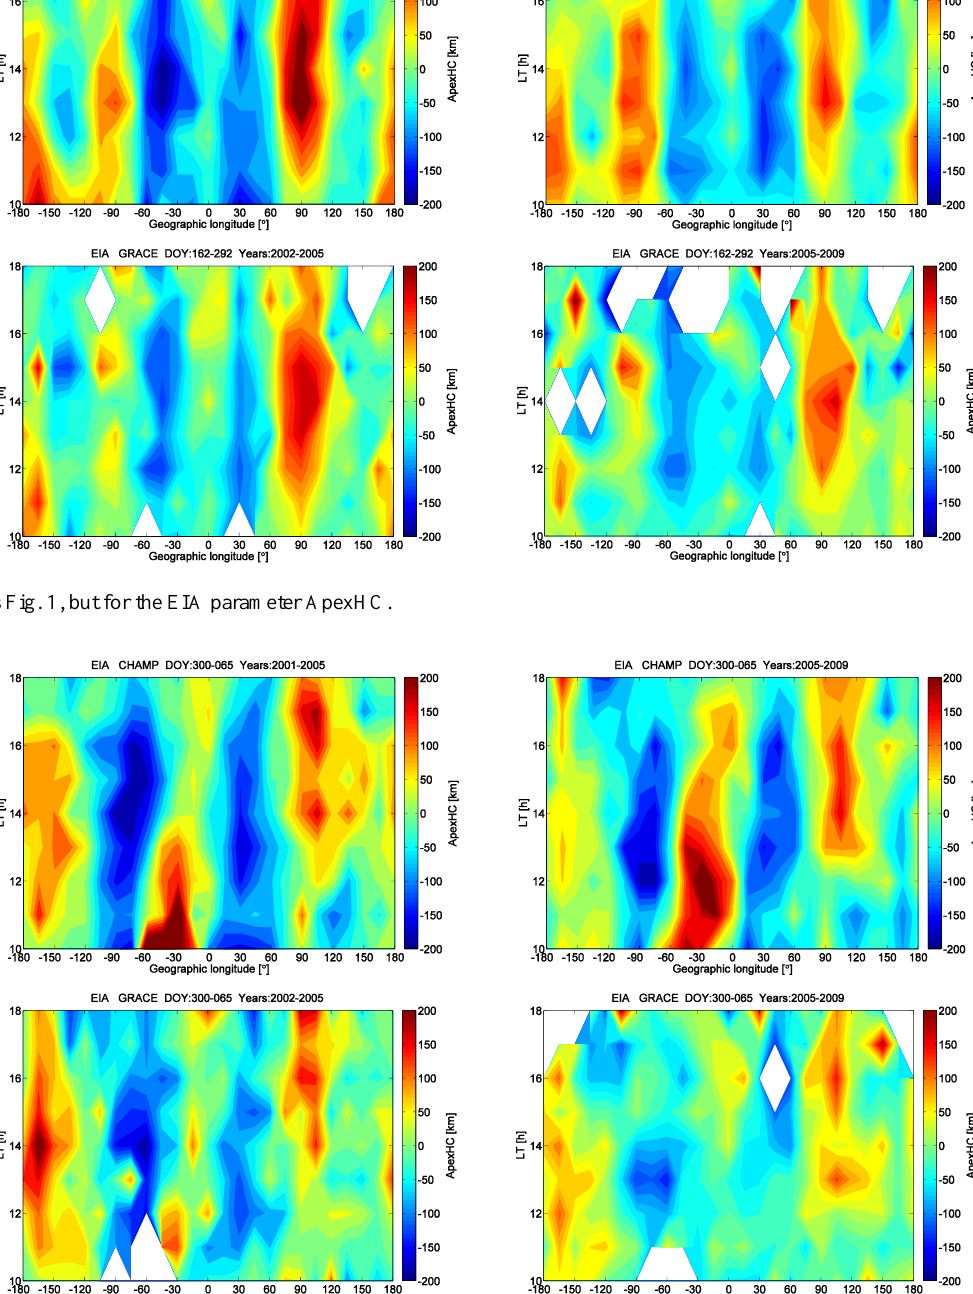
Fig. 3. The local time versus longitudinal distribution of the EIA parameter ApexHC from CHAMP (top) and GRACE (bottom) observations during higher (left) and lower (right) solar activity years around December; data are from DOY between 300 and 065.